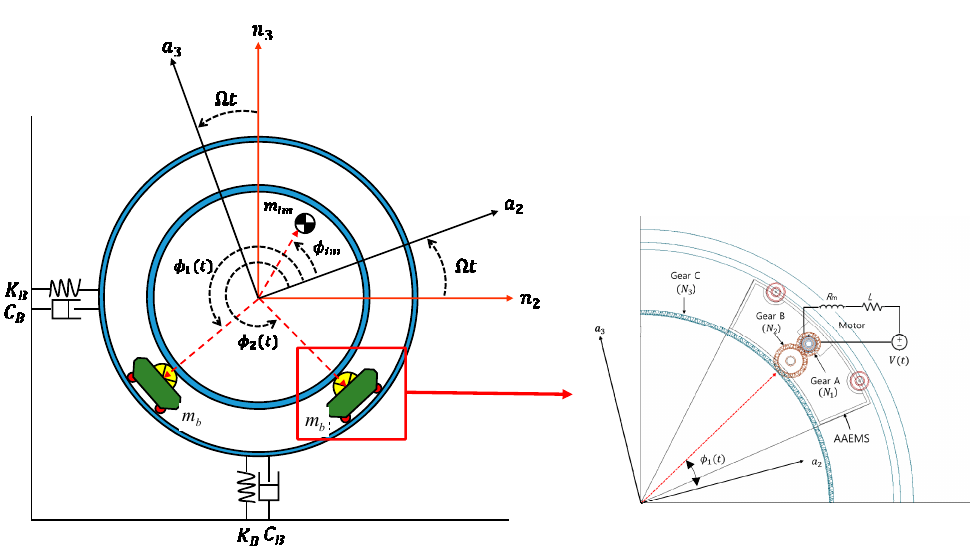
Figure 1. Imbalance rigid planar rotor with dual actively actuated eccentric mass system (AAEMS) supported by a symmetric passive linear bearing.